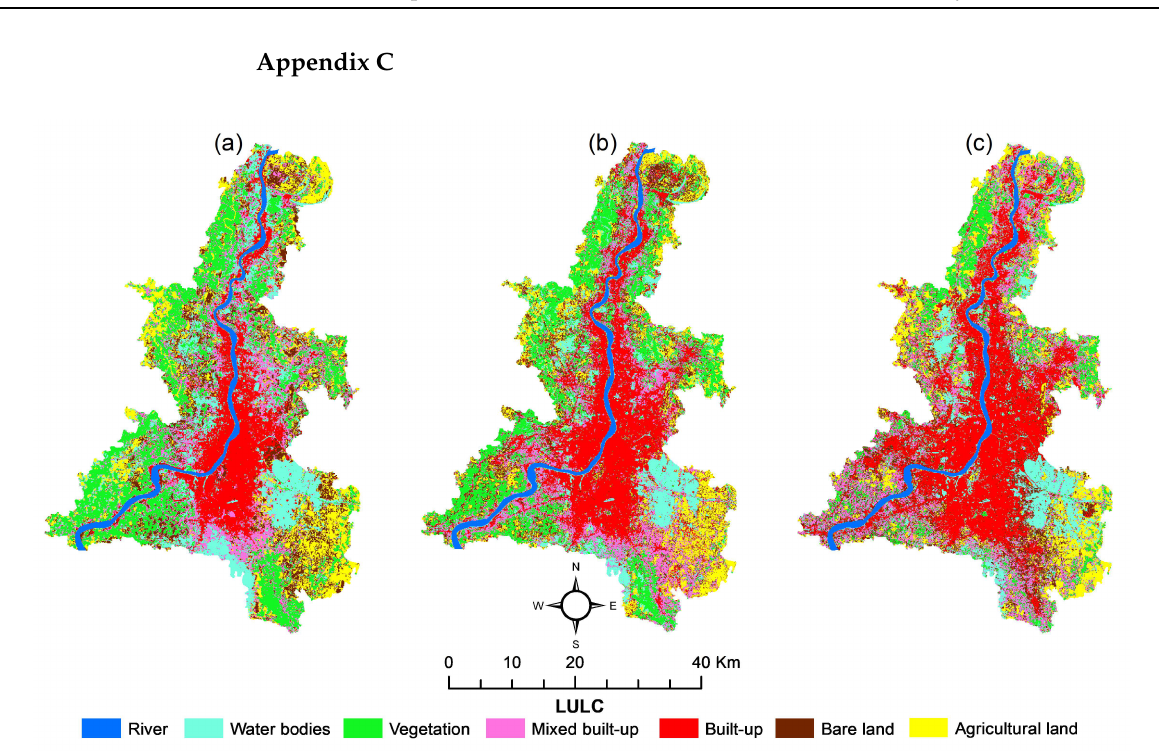
Figure A1. The SVM generated classified LULC maps of KMA for the selected years: ( a ) 1996, ( b ) 2006, and ( c ),